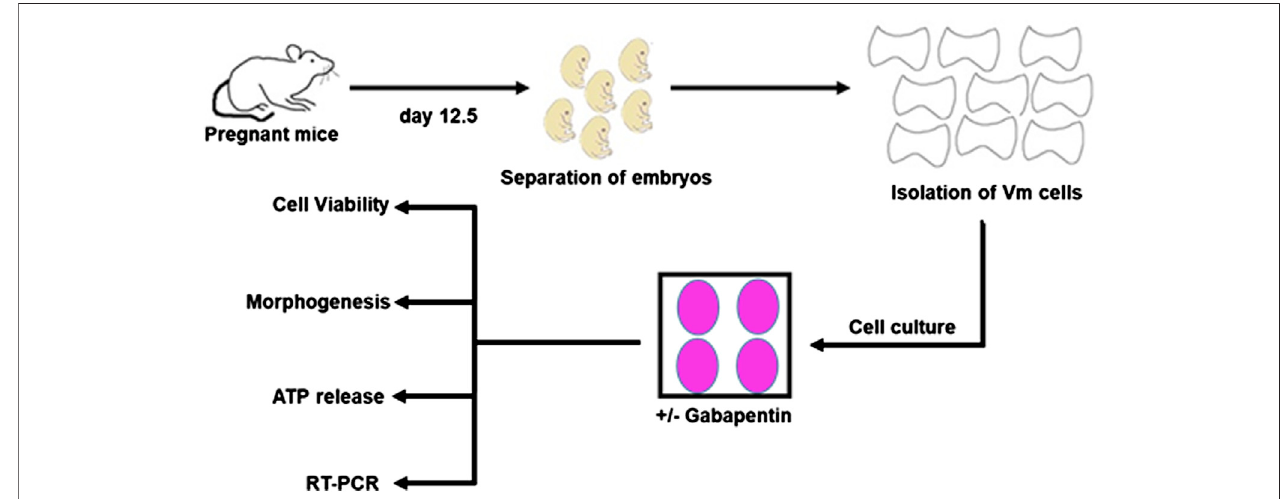
FIGURE 1 | The experimental design of the present